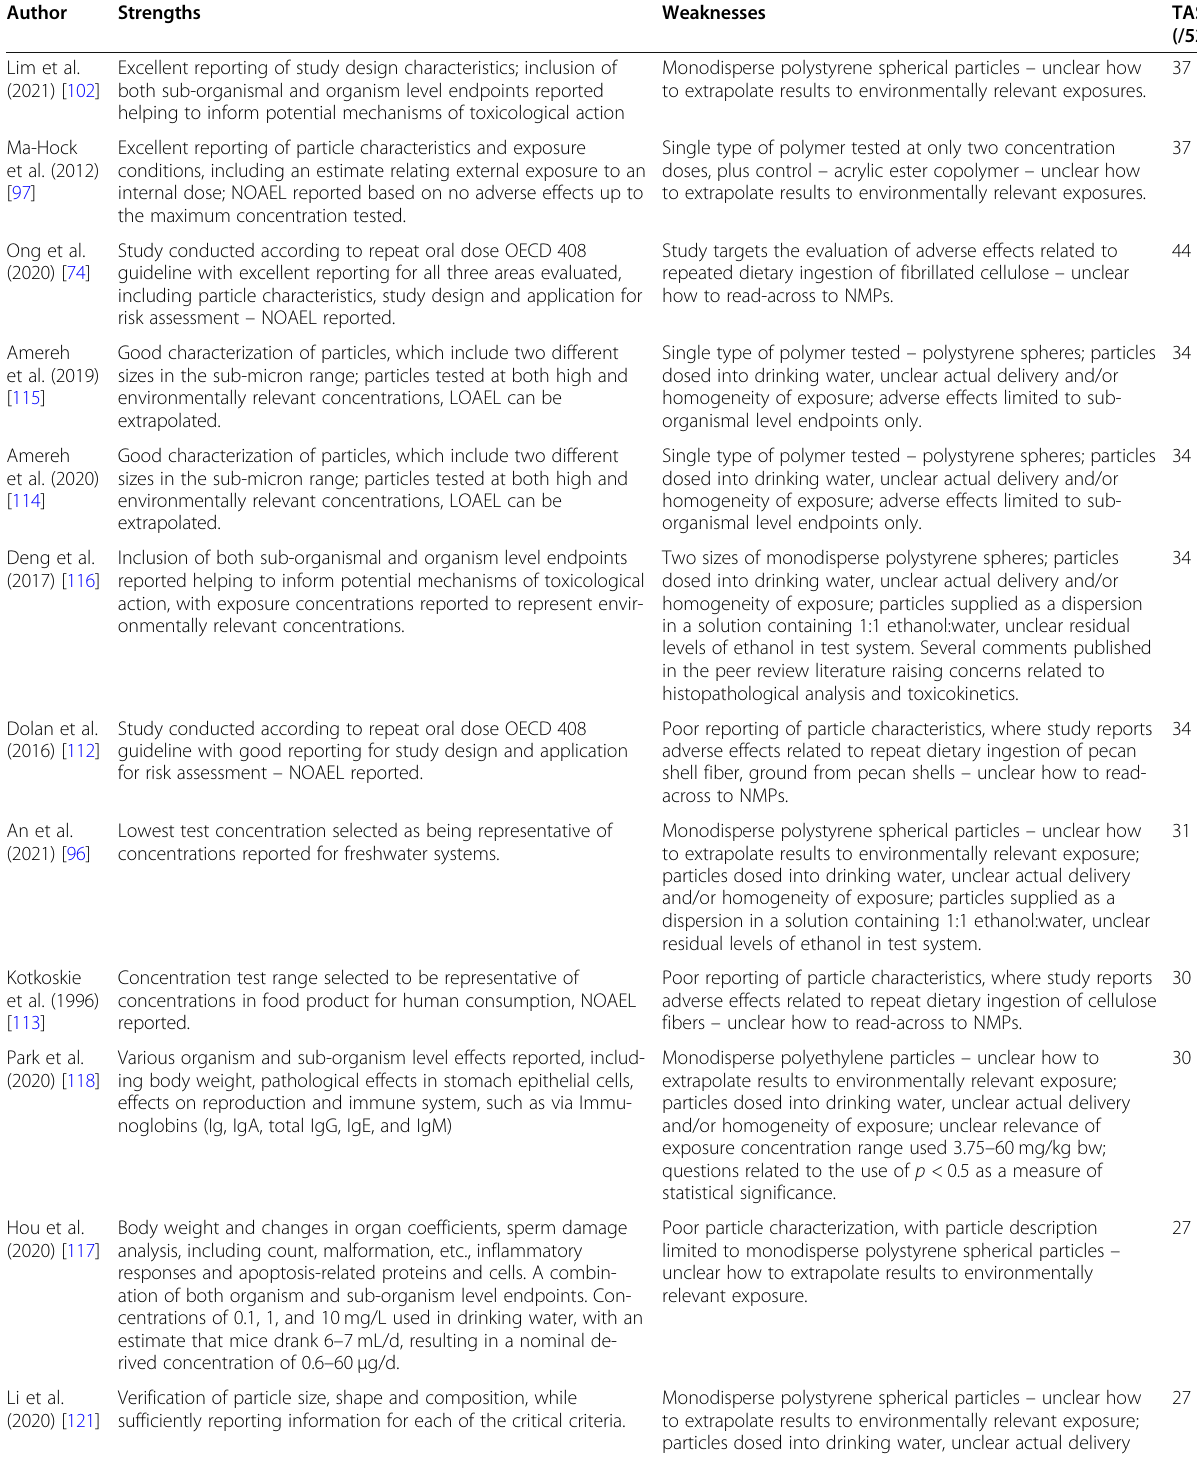
Table 1 Summary of total assessment scores (TAS) and QA/QC criteria strengths and weaknesses of in vivo studies prioritized based on adequate evaluation of critical QA/QC identified as part of a Tier 1 screening assessment. Strengths and weaknesses listed reflect how the data support or limit, respectively, the interpretation of study results within a risk assessment context. Strengths